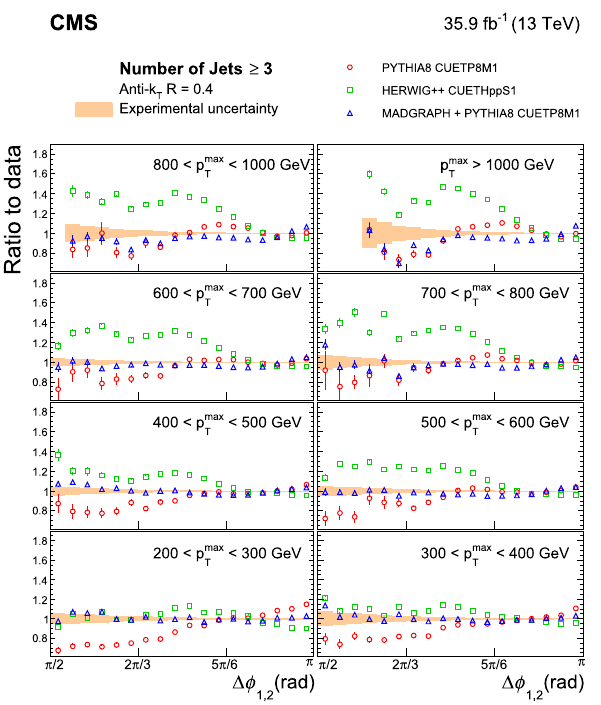
Fig. 6 Ratios of pythia 8, herwig++ , and MadGraph + pythia 8 predictions to the normalized inclusive 4-jet cross section differential in Δφ 1,2 , for all p max regions. The solid band indicates the total exper- T imental uncertainty and the vertical bars on the points represent the statistical uncertainties in the simulated